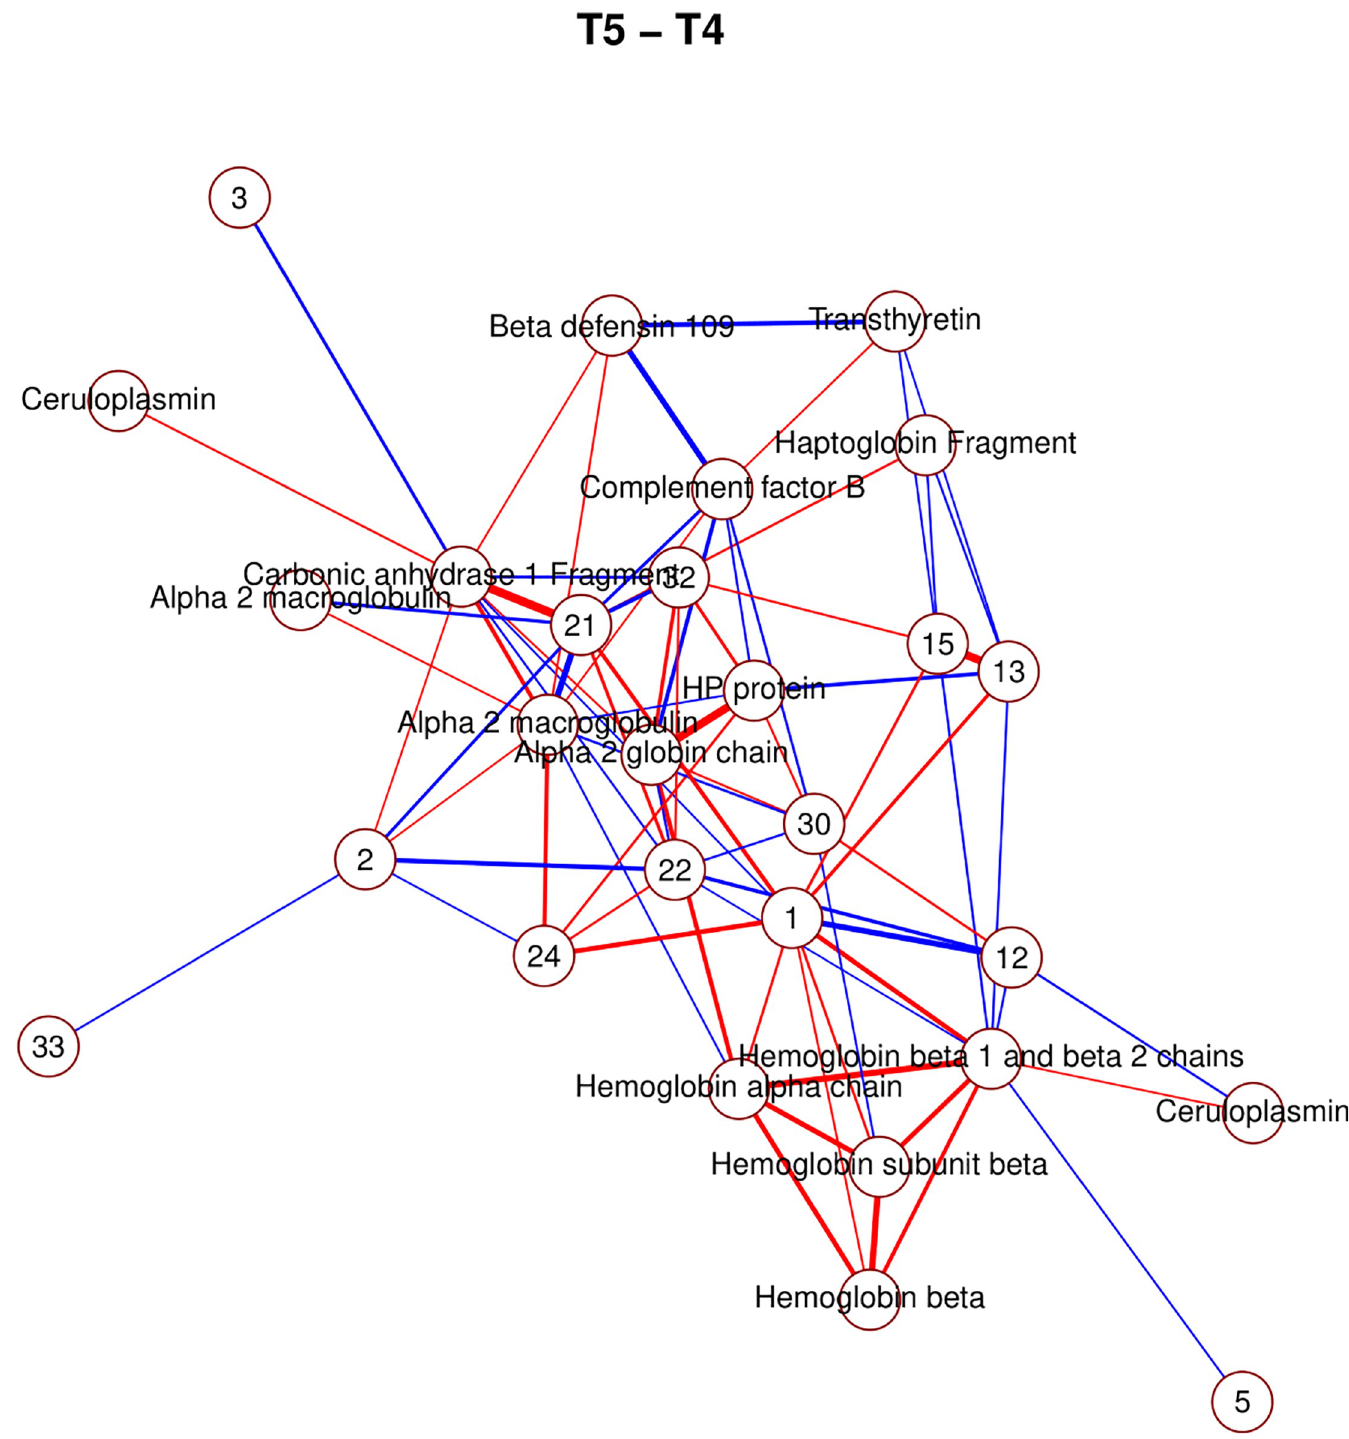
Fig 9. Non-zero partial correlations between differences in spot intensities from t 4 to t 5 displayed as a conditional independence network. Line width is proportional to the strength of the partial correlation and color represents positive (red) or negative (blue) partial correlation.